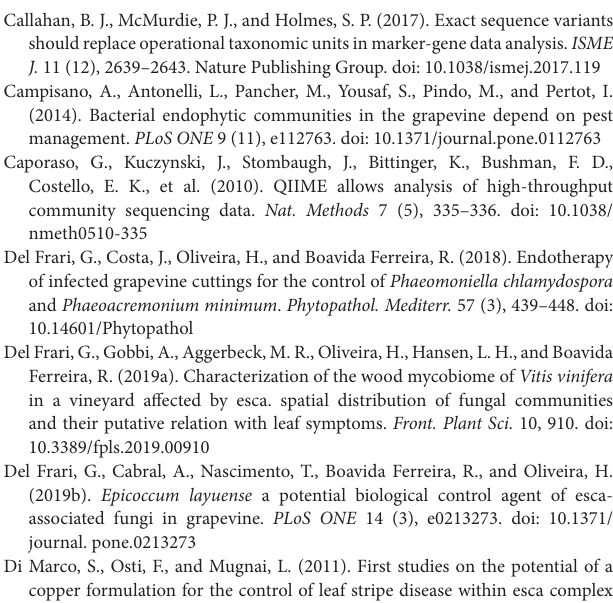
FIGURE S1 | Rarefaction curves of alpha-diversity indexes; each line correspond to one sample in a range from 0 to 18000 reads. Each box plot represent the distribution of the selected alpha diversity metric for each sample at each 2000 reads of sampling depth. The lower and upper whiskers of the box plot correspond to the 9th and 91st percentiles of the distribution, while the lower and upper extents of the box correspond to the 25th and 75th percentiles of the distribution (respectively). The horizontal bar through the middle of the box is the median of the distribution (i.e., the 50th percentile). Outlier points of these distributions are not shown. The lines connect all the medians from the different. A) Rarefaction curves based on richness, calculated on the number of amplicon sequence variants (ASVs). B) Rarefaction curves based on Shannon